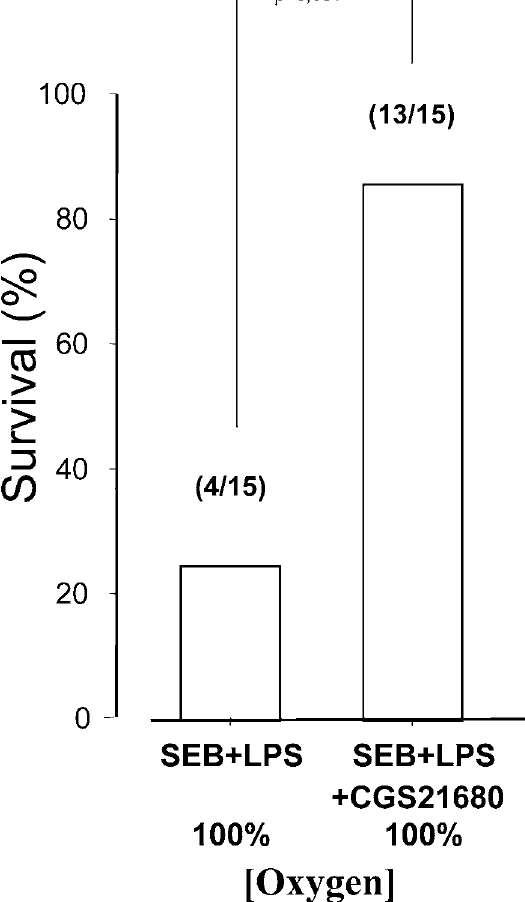
Figure 9. IT Administration of A 2A R Agonist Protects from Increased Death Rate upon Oxygenation of Mice with Acute Lung Injury Compensation for the oxygenation-associated loss of the hypoxia fi adenosine fi A 2A R signaling pathway by IT injection of CGS21680 significantly decreased the oxygen-exacerbated death rate in mice with acute lung injury induced by IT injection of SEB and LPS. For further explanation, see legend for Figure 1. DOI: